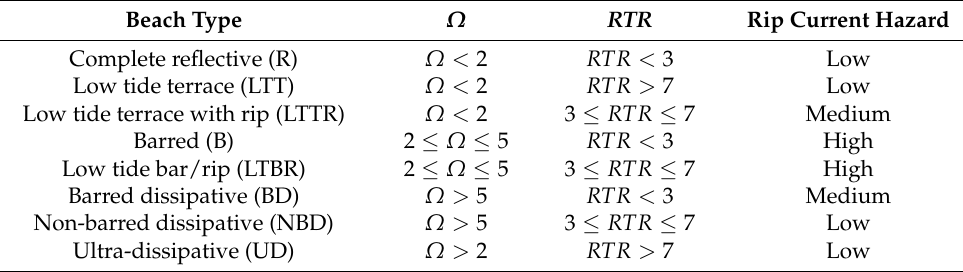
Table 2. Beach state classification based on RTR and Ω parameters.